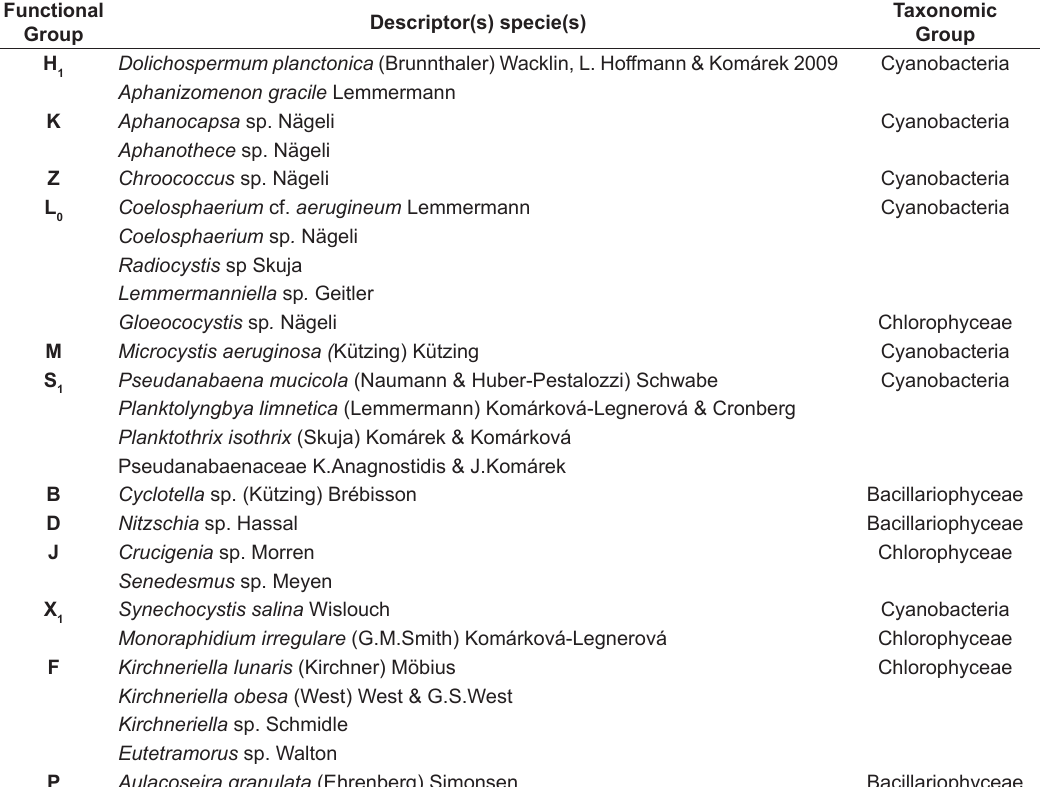
Table 1. Functional groups, descriptor species and corresponding taxonomic groups found during rainy and dry seasons in microcosm